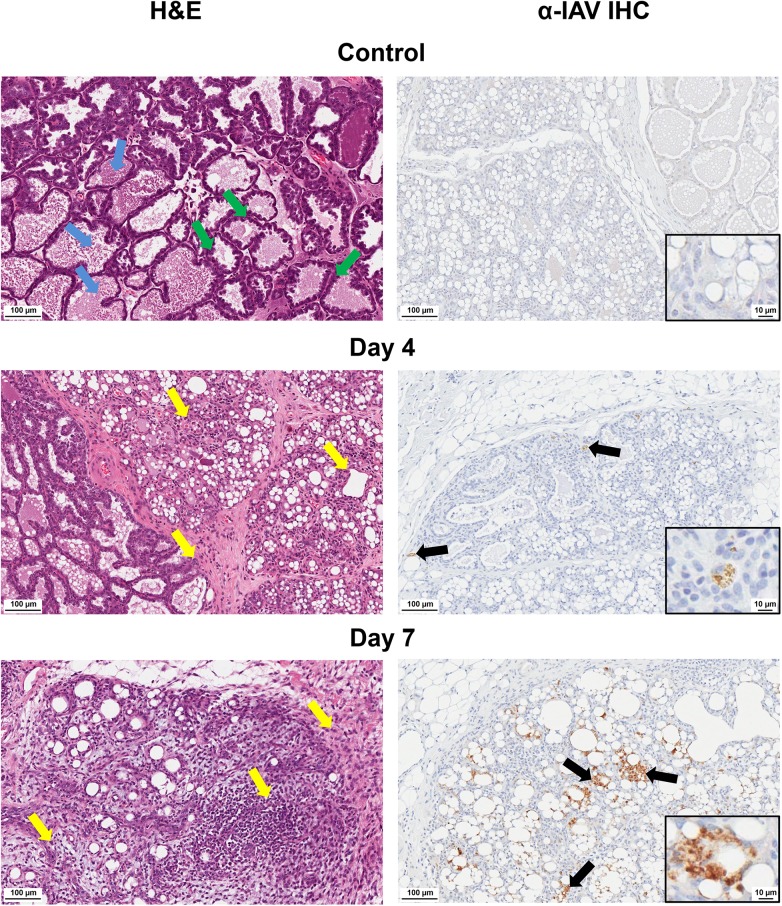
Destruction of acini and accumulation of viral protein in mammary glands of mothers of infected infants.Pathological destruction was determined by H&E (left) and IHC for IAV (right) analysis of paraffin-embedded mammary sections from nursing-mothers of infected infants. Black arrows denote areas of virus expression determined by anti-IAV staining. Yellow arrows denote areas of leukocyte infiltration. Blue arrows show milk protein accumulation. Green arrows indicate active epithelial cell layers. Control = mammary glands from nursing-mothers of mock inoculated infants. Samples were collected and analyzed from at least 3 independent litter inoculated/infected infants and 3 mothers per time point. Results show are representative of 3 litters per time point. Mother ferrets have variable numbers of active mammary glands per pregnancy/postpartum.